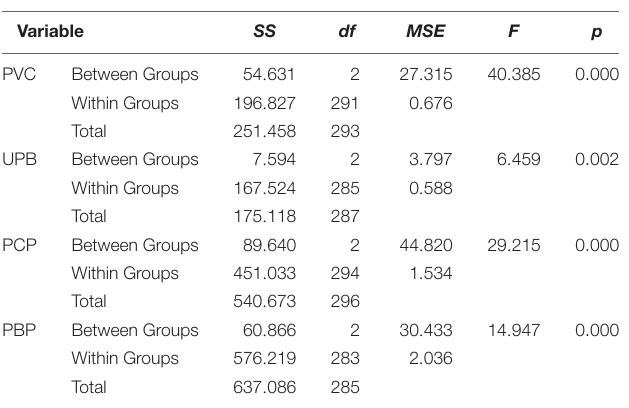
TABLE 12 | ANOVA tables – the three OID profiles.